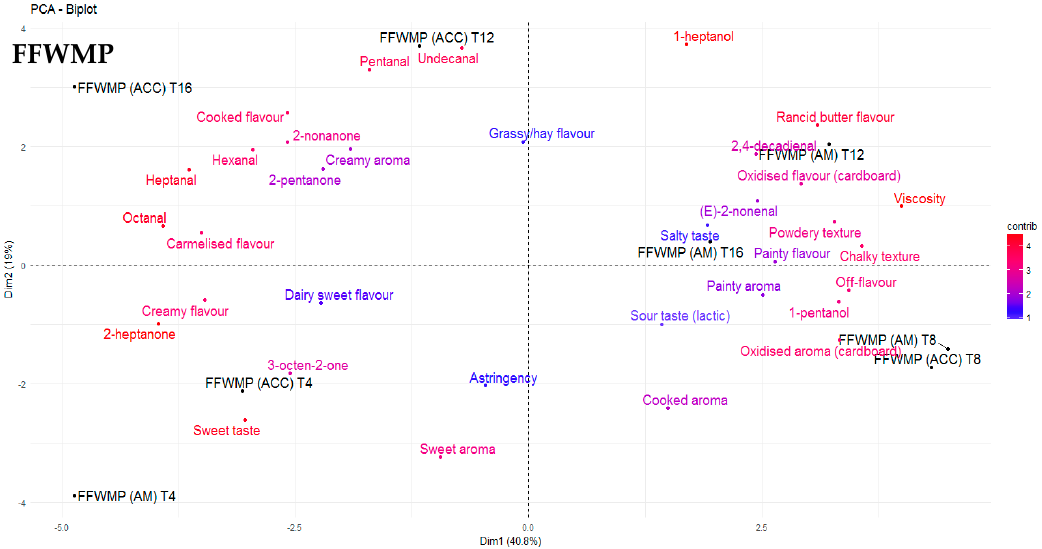
Figure 3. Principle component analysis (PCA) biplot demonstrating the correlations between the sensory perception and volatile compounds for fat-filled whole milk powder (FFWMP) at T4, T8, T12, and T16 of storage. AM: ambient, 21 °C; ACC: accelerated, 37 °C.